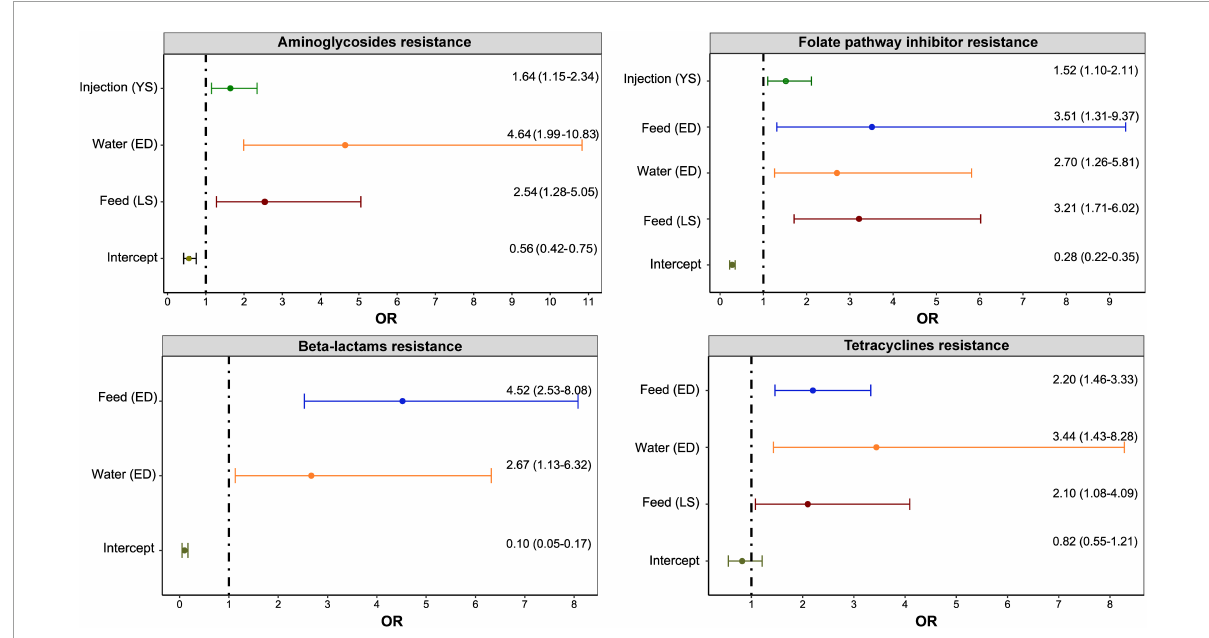
FIGURE3 Significant associations between antimicrobial use via a specific route for a specific disease and resistance to antimicrobial classes in E. coli isolates ( n = 1,317) of turkeys. Any antimicrobial class used on the Canadian turkey flocks was included in the multivariable mixed-effects logistic regression model with flocks, years, and sampling networks included as random intercepts. The figure included only significant associations determined. The x -axes show an odds ratio (OR) that is represented as a point and the line represents the 95% Confidence Intervals. The y -axes with “(YS)” represent yolk saculitis, “(ED)” – enteric diseases, and “(LS)” – late-stage septicemia.